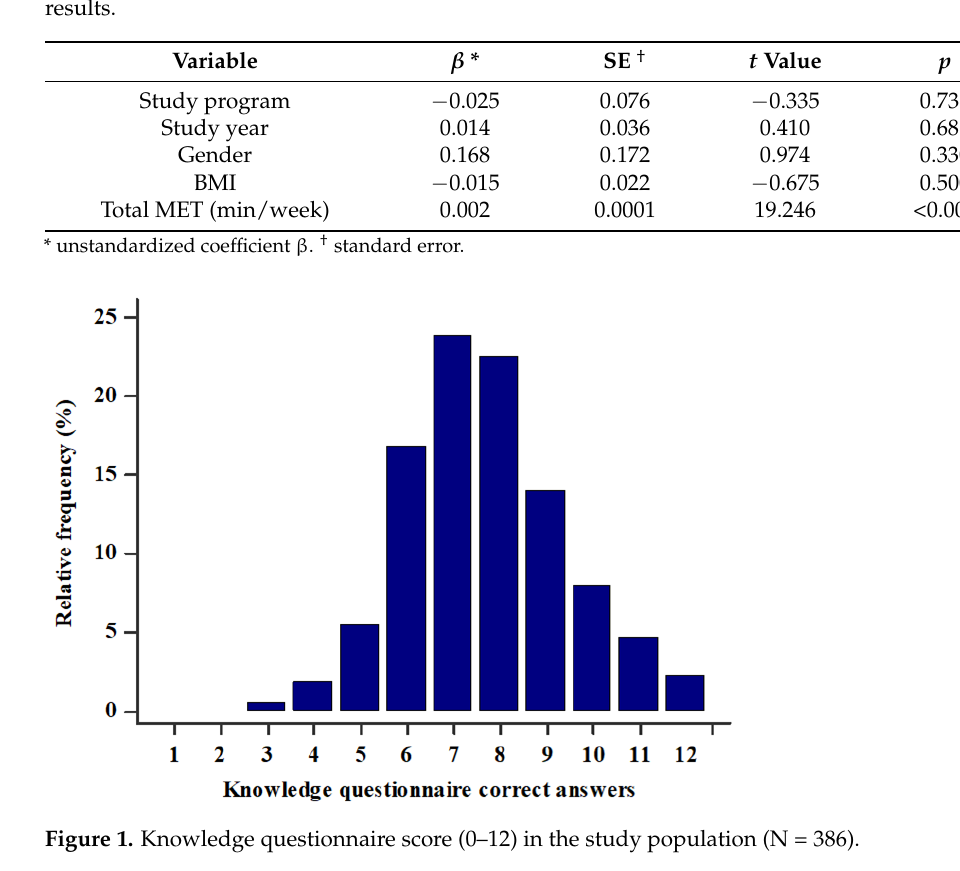
Figure 2. Correlation between total MET scores and knowledge questionnaire score (0-12). Table 5. Multiple linear regression model of independent predictors for knowledge questionnaire results.